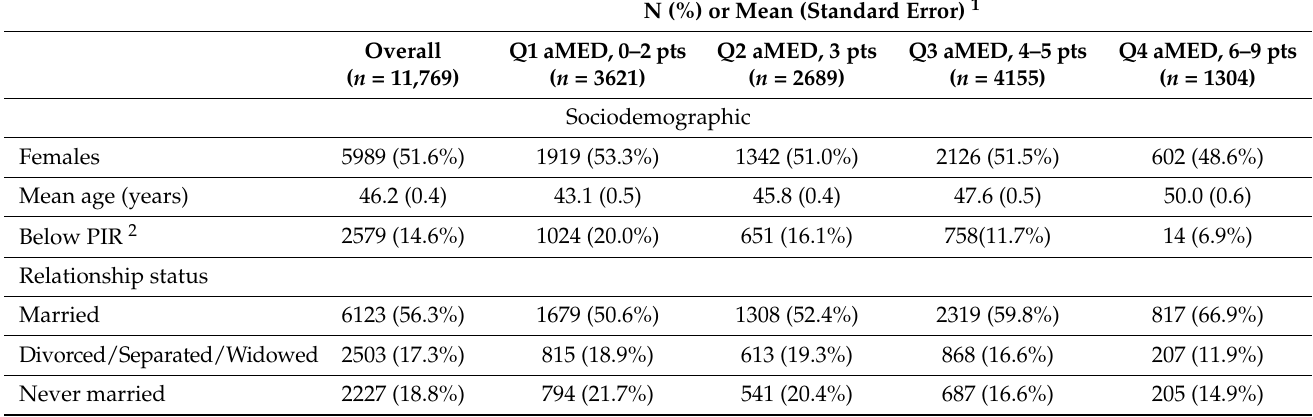
Table 1. Selected characteristics of adult men and women overall and by Alternate Mediterranean Diet (aMED) score quartiles, National Health and Nutrition Examination Survey (NHANES)